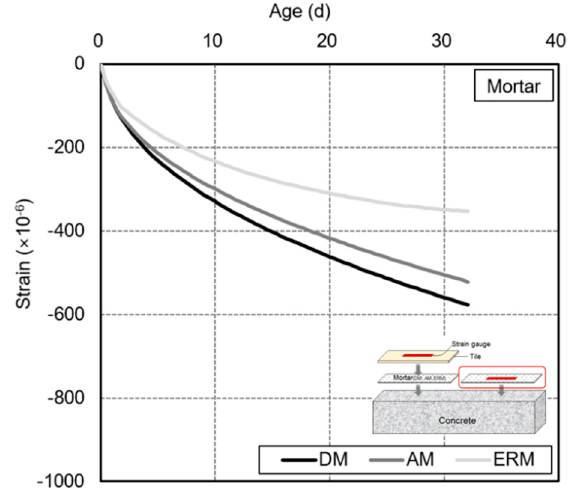
Figure 11. Drying shrinkage of mortar.